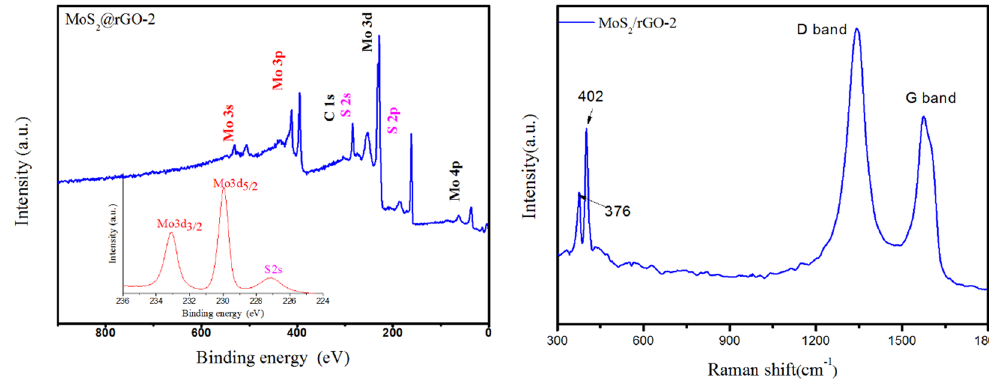
Figure 2. ( a ) XPS spectrum of MoS 2 @rGO-2 composite and the peaks of Mo 3d in the inset graph, ( b ) Raman spectrum of the